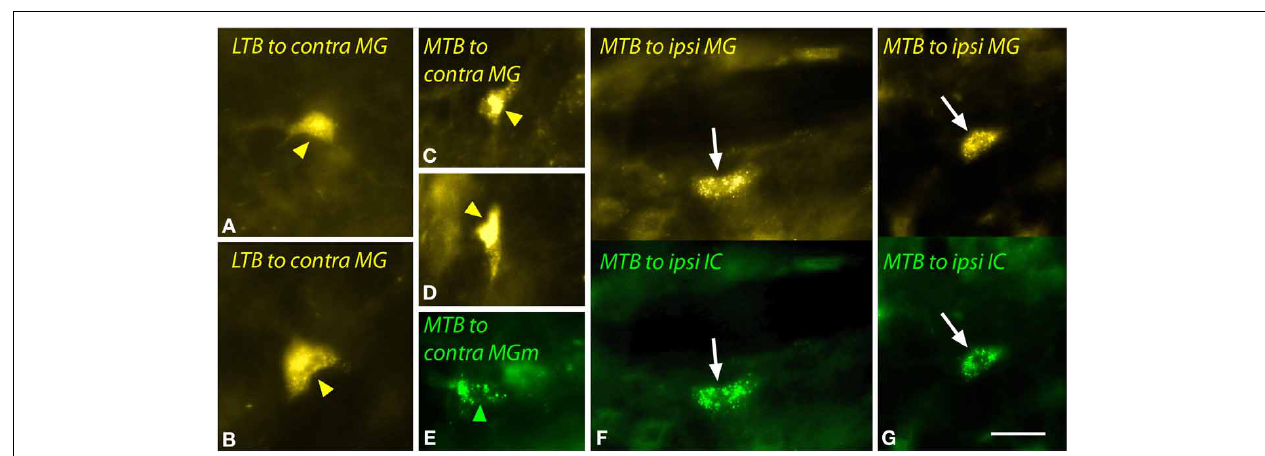
FIGURE 8 | Photomicrographs showing labeled cells in the lateral nucleus of the trapezoid body (LTB) or the medial nucleus of the trapezoid body (MTB) after injections into the medial geniculate nucleus (MG) and the inferior colliculus (IC). (A,B) Cells (yellow arrowheads) in the right LTB labeled by a large injection of FluoroGold into the left MG (GP597). (C,D) Labeled cells (yellow arrowheads) in the right MTB after a large injection of FluoroGold into the left MG (GP597). (E) Cell (green arrowhead) in the left MTB labeled by a small injection of green beads into the right MG